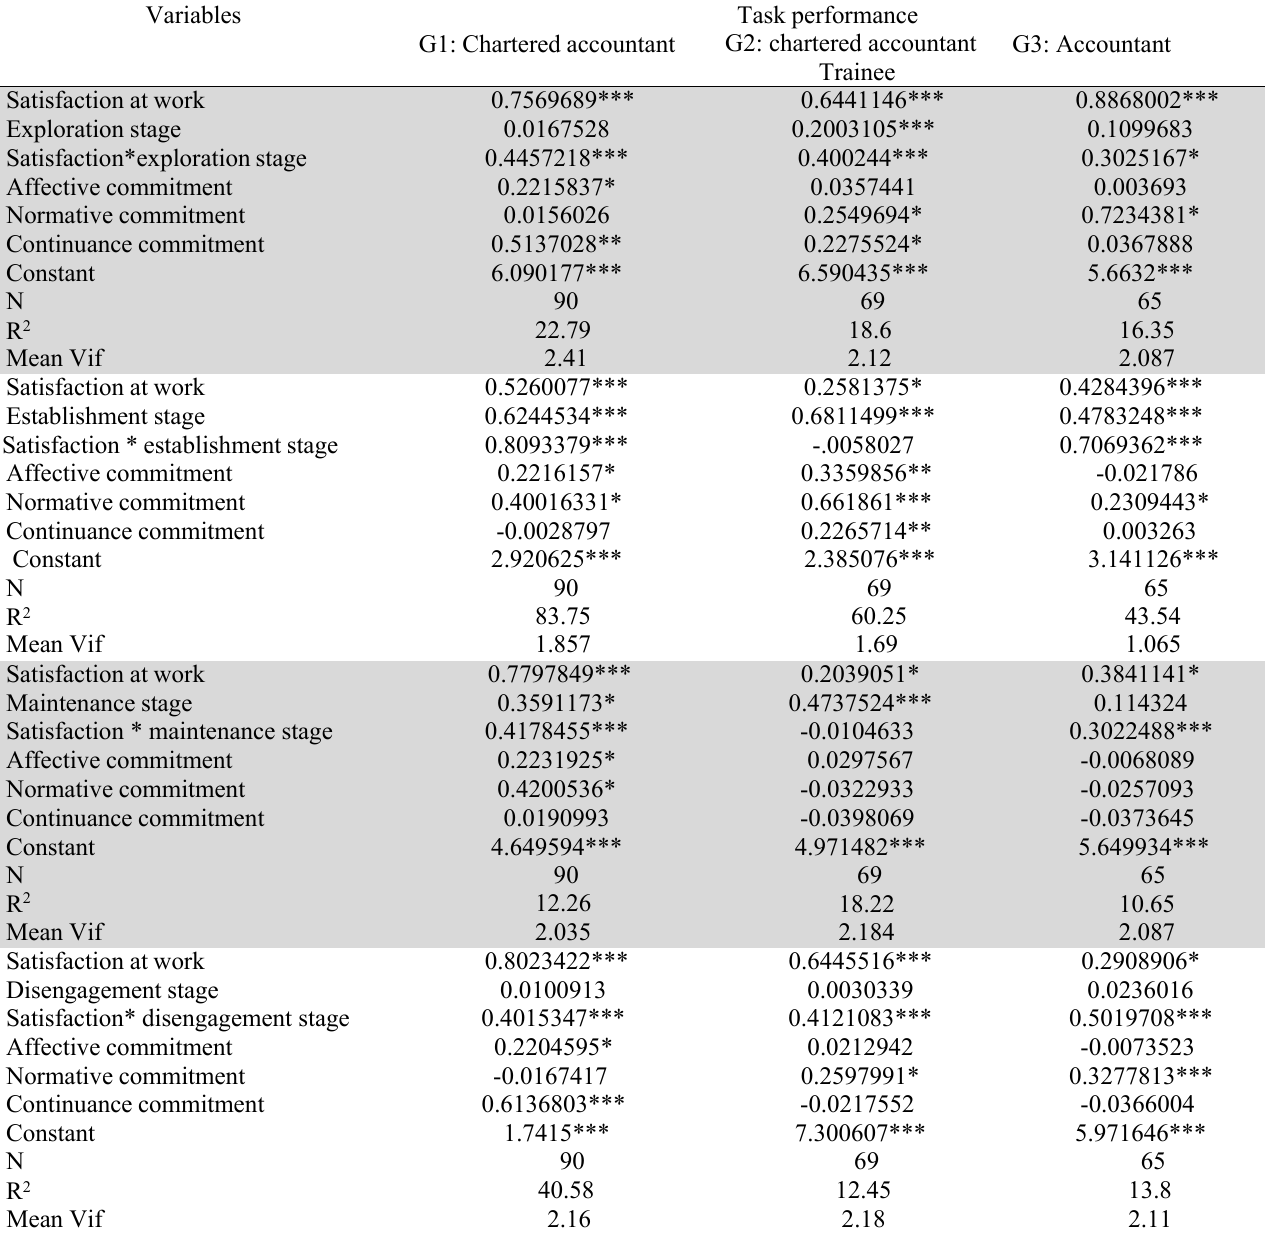
TSLS results with bootstrap (95% CI) Dependent variable: Task performance using a structural